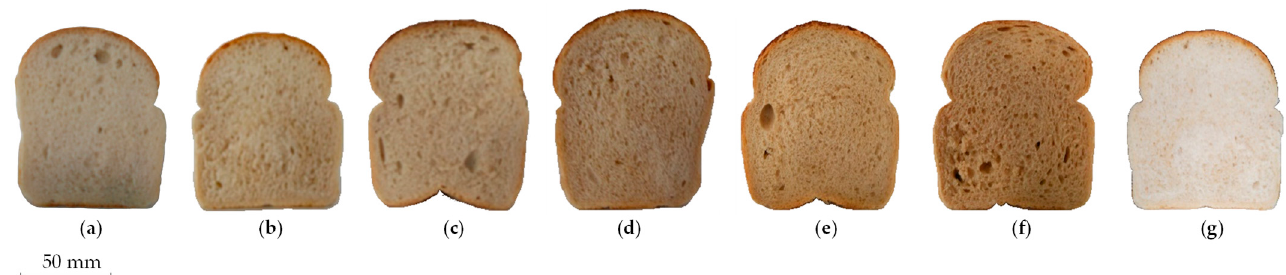
Figure 6. Images of bread samples: ( a ) control; ( b ) bread with 0.5% w / w Rp; ( c ) bread with 1.0% w / w Rp; ( d ) bread with 1.5% w / w Rp; ( e ) bread with 2.0% w / w Rp; ( f ) bread with 2.5% w / w Rp; ( g ) bread with 2 mg AA/100 g.